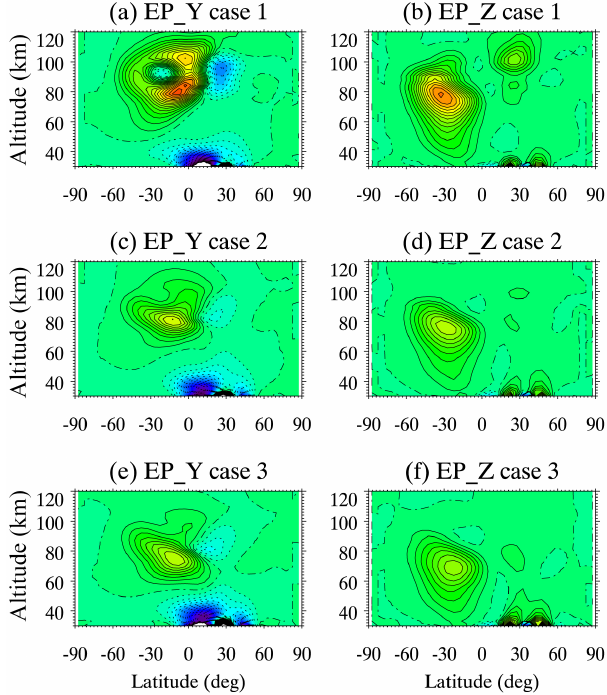
Figure 8. Meridional (left) and vertical components (right) of the EP flux of the W3 during model days 25–30 for (a, b) case 1, (c, d) case 2, and (e, f) case 3. The solid contours are for northward or upward directions. Both components have been normalized by the air